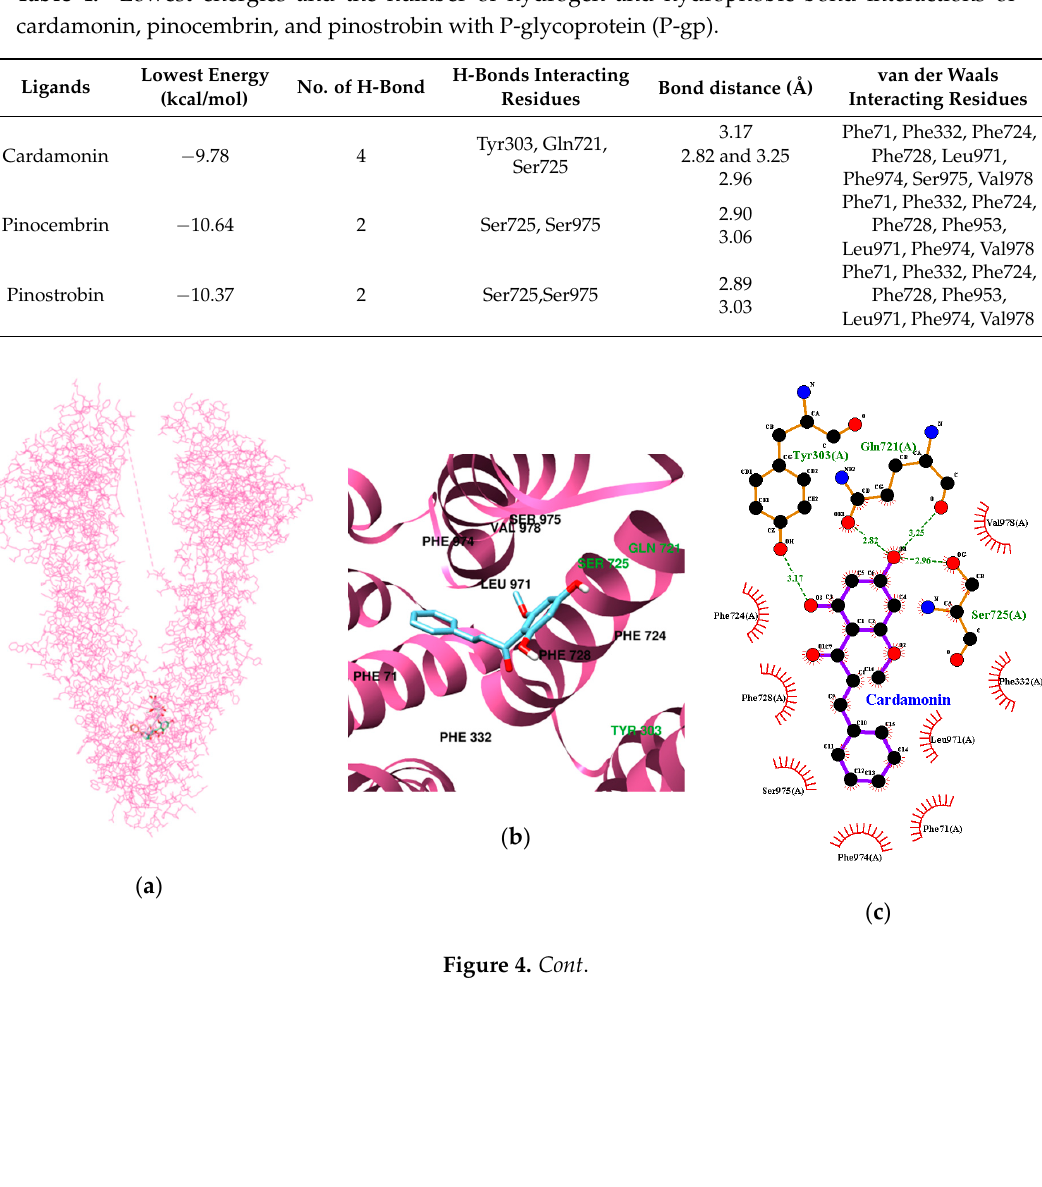
cardamonin, pinocembrin, and pinostrobin with P-glycoprotein (P-gp).